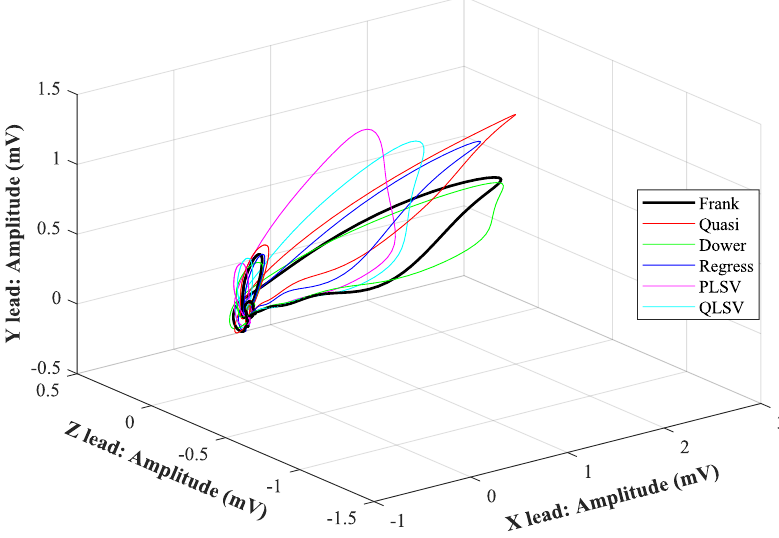
Figure 8. Comparison of transformation methods in 3-D, random patient